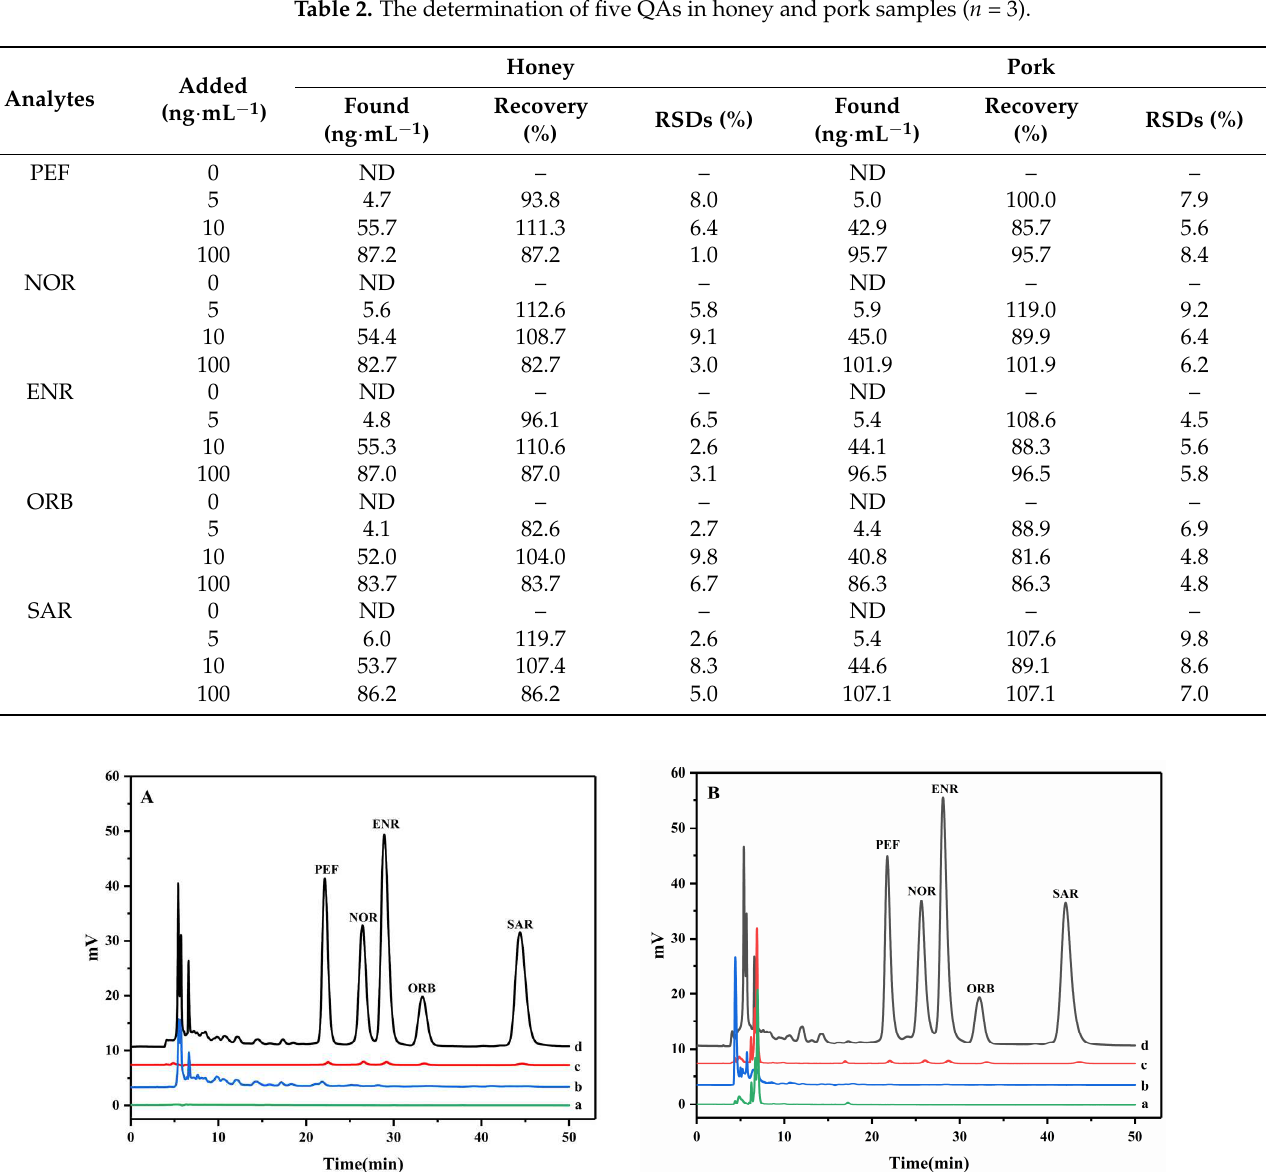
Table 3. Comparison of some methods for the determination of QAs.